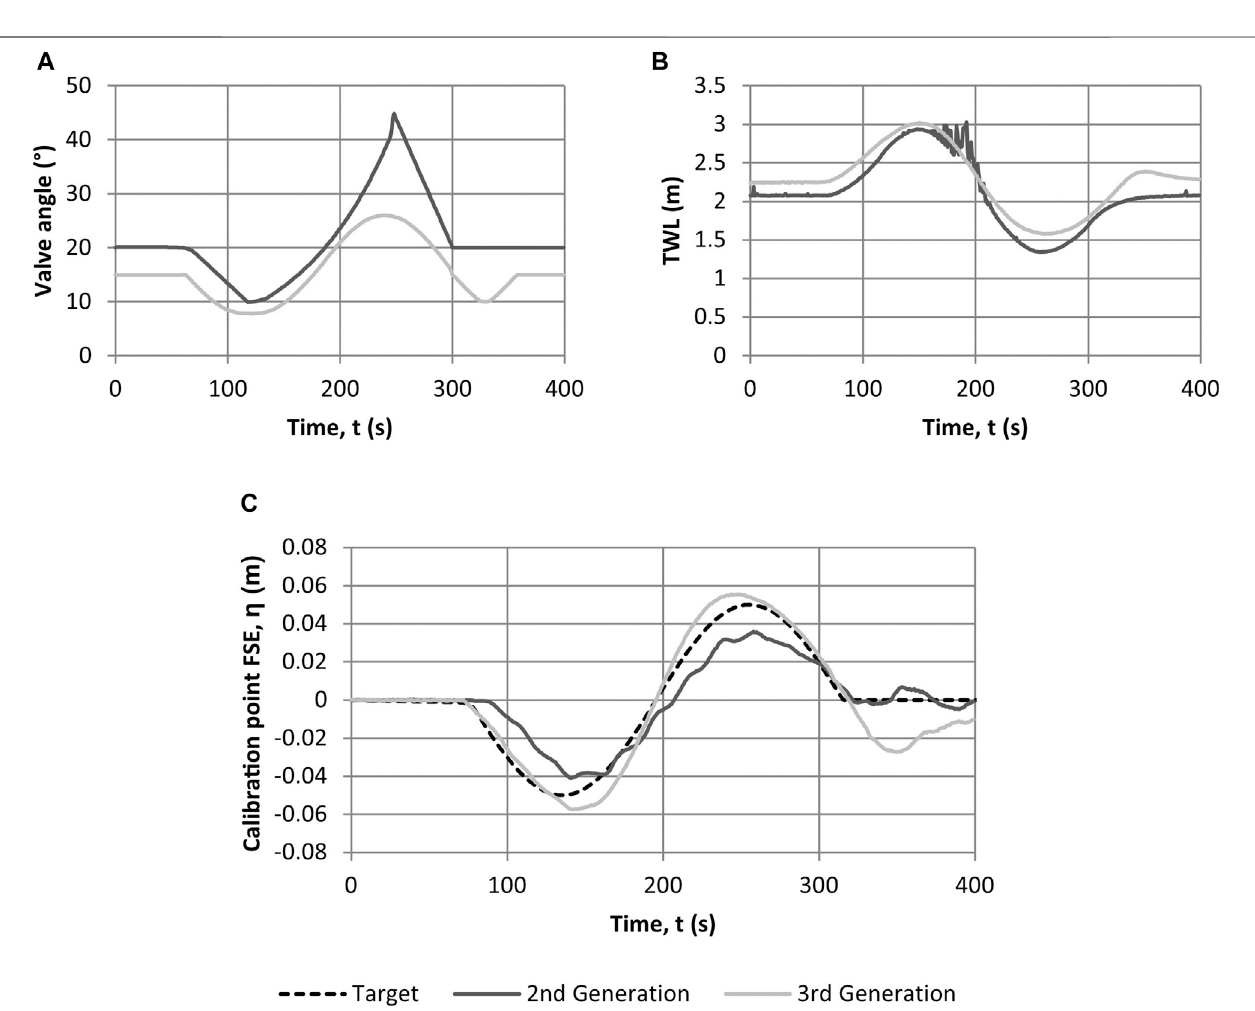
FIGURE 12 | Calibrated Mercator (A) and Tohoku (B) tsunami time series at 1:50 scale using third Generation TS.